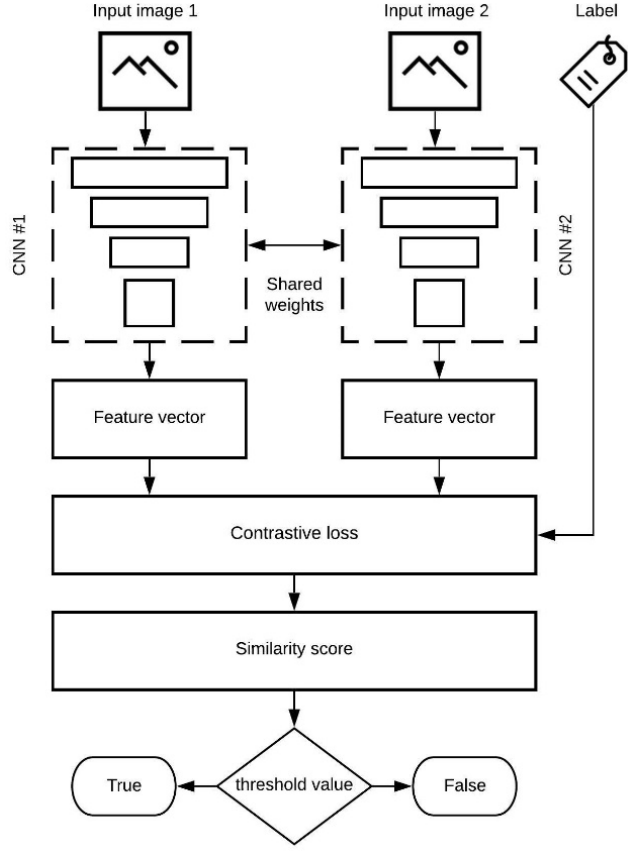
Figure 4. Basic concept of used the Siamese CNN model.